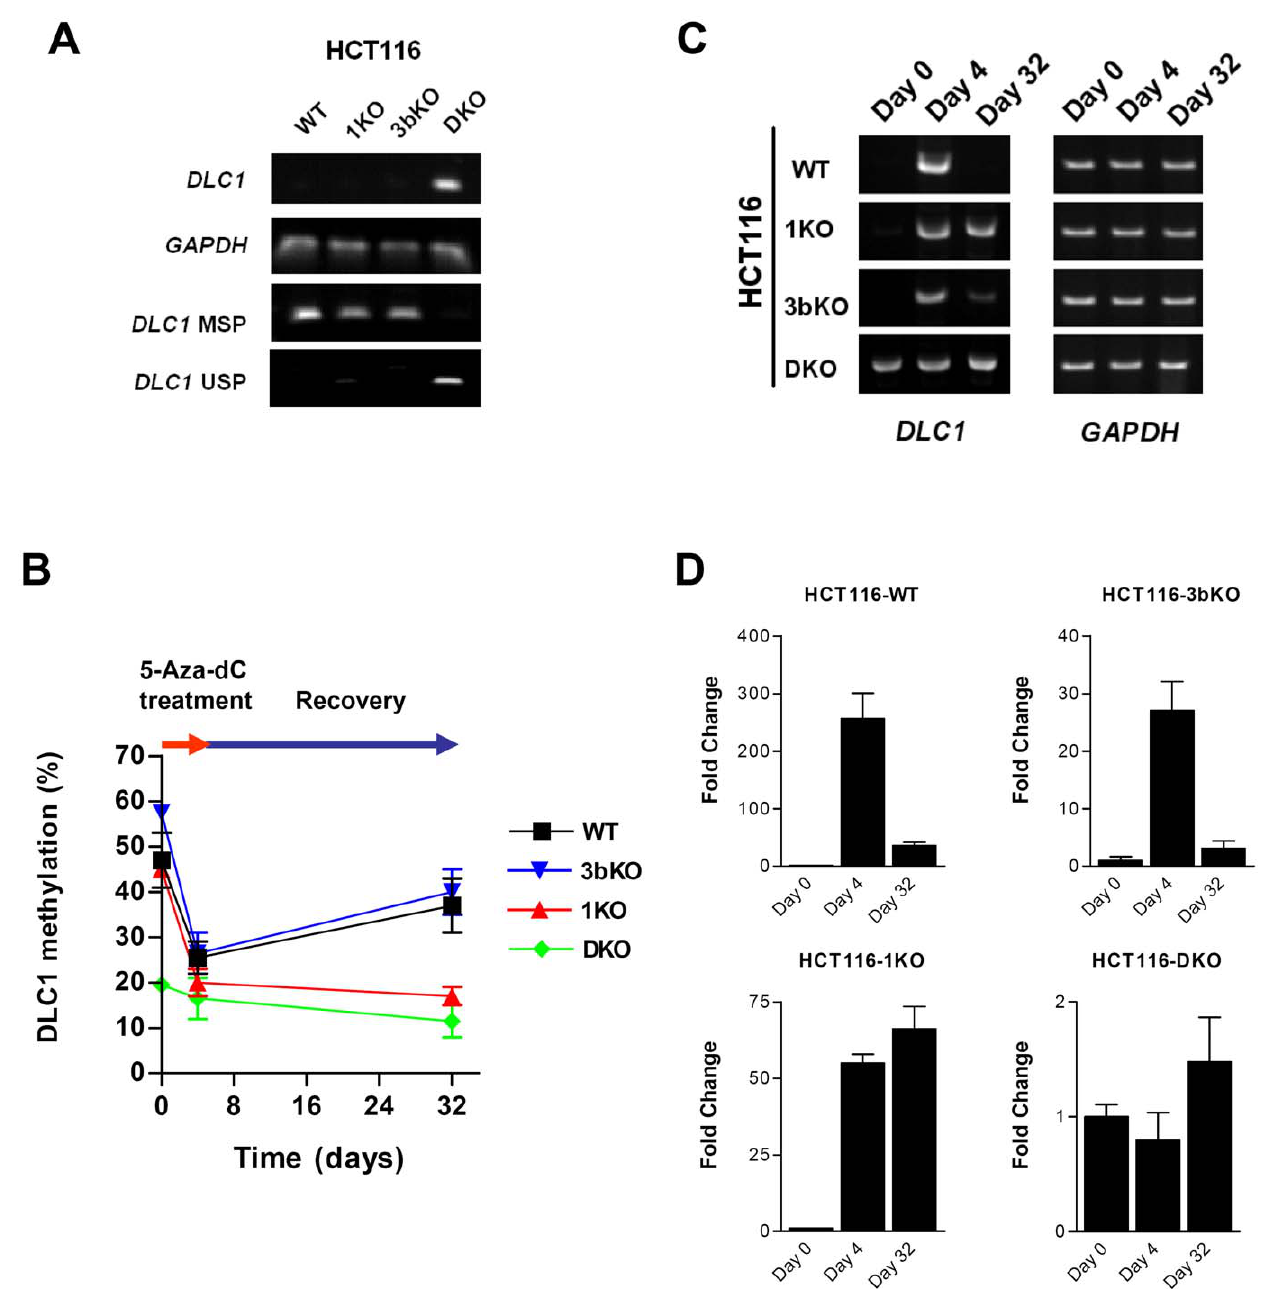
Figure 2. DNMT1 was indispensable for DNA methylation recovery. (A) DLC1 was silenced by DNA hypermethylation in parental HCT116 cells but was substantially expressed in double knockout (DKO) cells. (B) Re-methylation of the DLC1 CpG island in HCT116 cells after 5-Aza-dC treatment was quantitatively determined by pyrosequencing. DNMT1 knockout (1KO) cells failed to restore DLC1 promoter methylation. In contrast, DNMT3B knockout cells (3bKO) re-acquired DLC1 promoter methylation as efficiently as parental HCT116 cells. Consistently, 1KO and DKO cells were unable to re-silence DLC1 gene expression, in contrast to that observed in parental HCT116 and 3bKO cells. Re-silencing of DLC1 mRNA expression in HCT116 cells was determined by semi-quantitative (C) and real-time quantitative RT-PCR (D). DLC1 expression was normalized against GAPDH and HPRT, respectively. Data are represented as mean 6 SEM from three independent experiments.